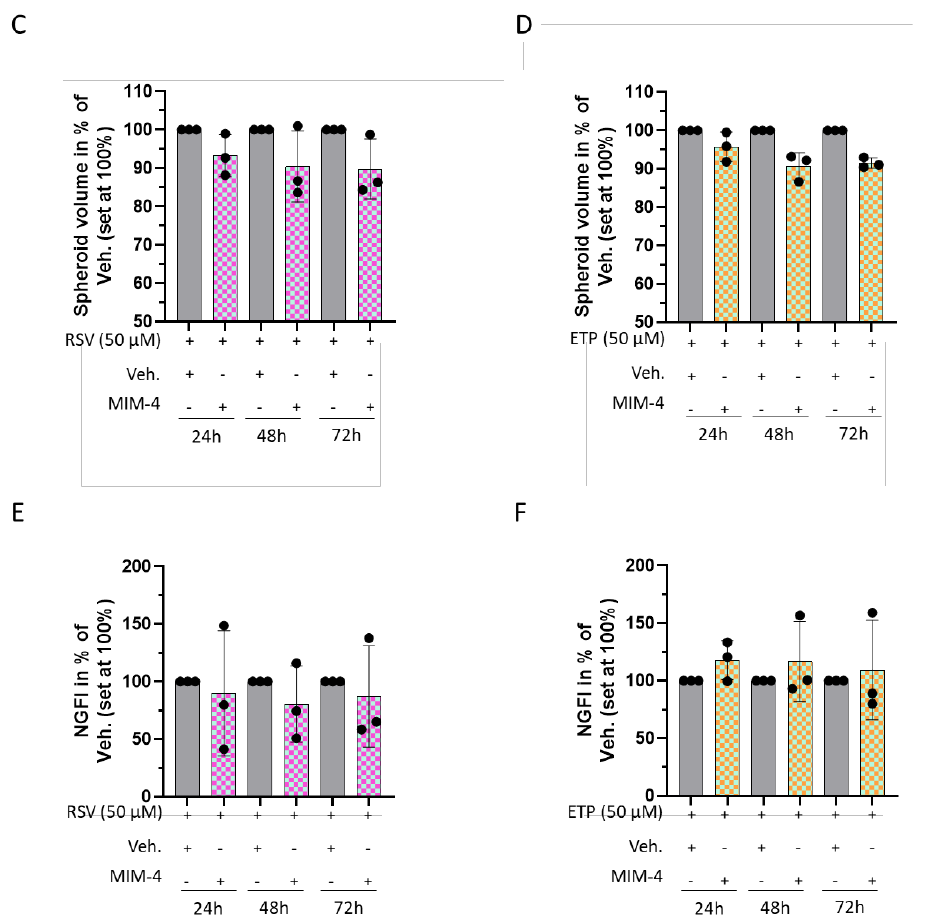
Figure 5. MIM-4 could act as an adjuvant when associated with etoposide or resveratrol, in an in vitro 3D-spheroid model of CRC. ( A ) Spheroids were cultivated in standard conditions and treated for 24, 48 or 72 h with either ETP (orange curve) or RSV (pink curve), at 50 µ M each. Spheroids cultivated in standard conditions without any treatment were used as a positive control (Ctrl). Spheroid volumes were calculated and the growth evolution was represented as the fold change of the initial spheroid volume at the time of the treatment initiation. Results are presented as the growth mean ± SD for each condition ( n = 3). ( B ) The cytotoxicity of both ETP and RSV was appraised in the same conditions as described in ( A ). The results are presented as the mean normalized green fluorescence intensity (NGFI) ± SD from CellTox green fluorescent dye, for each condition ( n = 3). NGFI was calculated as described in Section 4.4.3. Spheroids were cultivated in the presence of RSV ( C ) or ETP ( D ) for 24, 48, or 72 h, concomitantly with either the Veh. (grey histograms) or MIM-4 (squared histograms) and the spheroid volumes were calculated in each condition. The results are presented as the mean ± SD of the volume percentage, the Veh. conditions being set at 100% ( n = 3). The cytotoxicity of the association of RSV with either Veh. or MIM-4 ( E ) and the cytotoxicity of the association of ETP with either Veh. or MIM-4 ( F ) was appraised in the same assessed conditions as in ( B , C ). The results are presented as the mean ± SD of the NGFI percentage, the Veh.-conditions being set at 100% ( n =